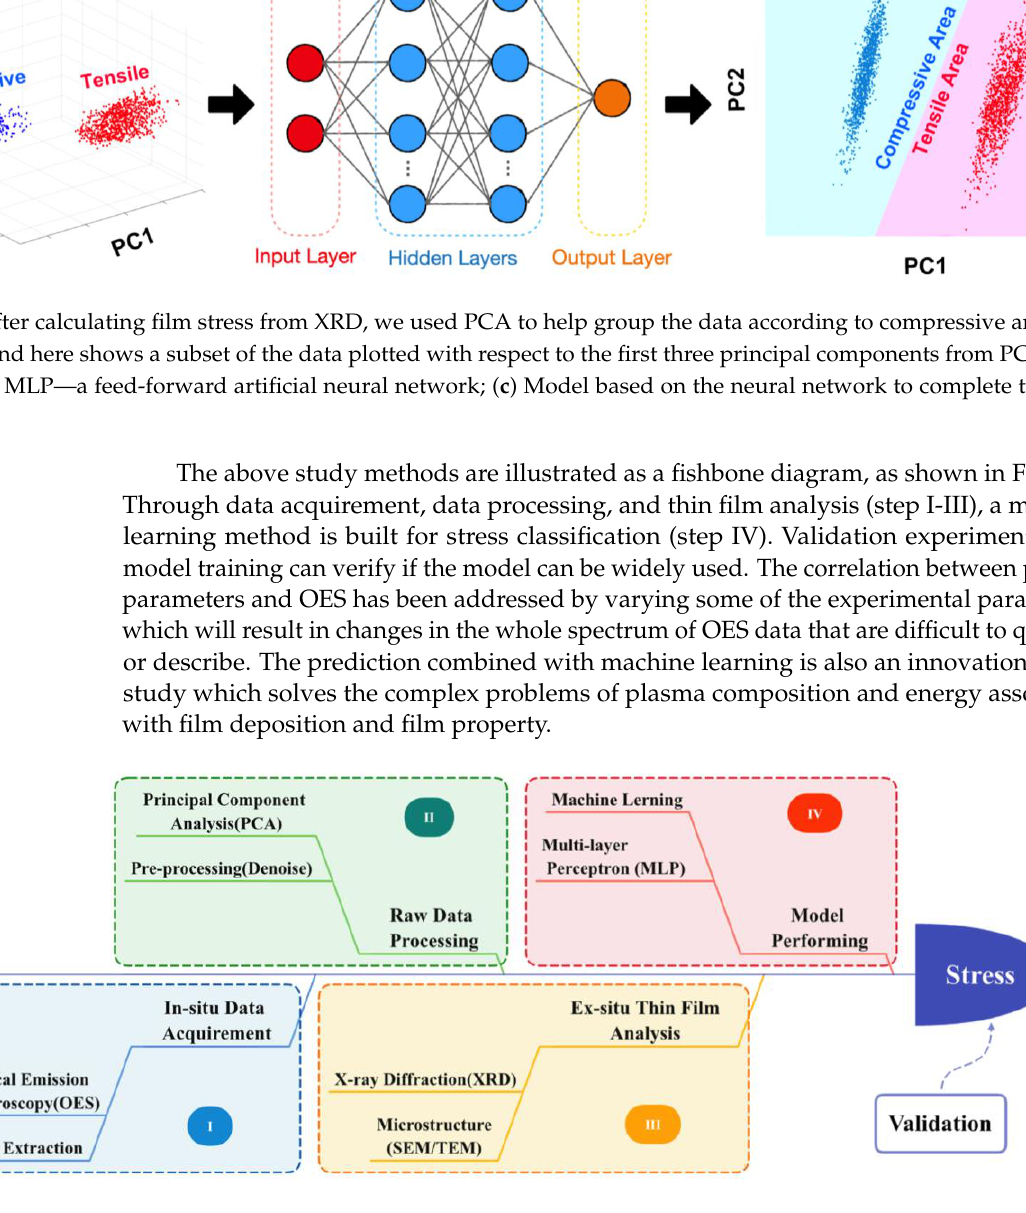
Figure 4. Schematic diagram including four steps in this study.